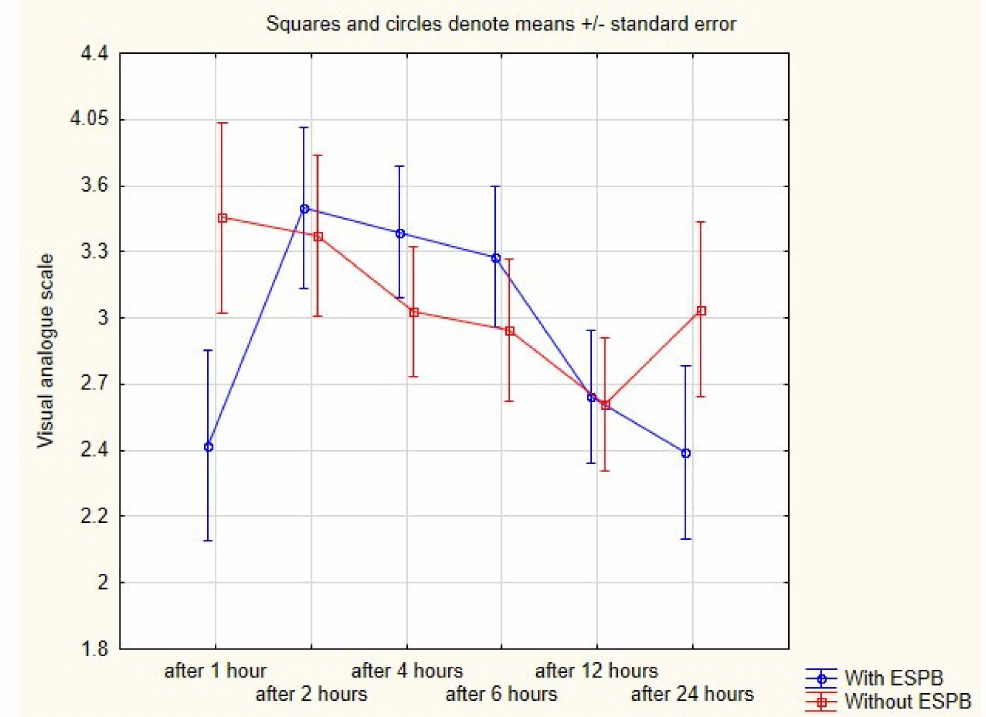
Figure 2. Visual analogue scale after operation in both